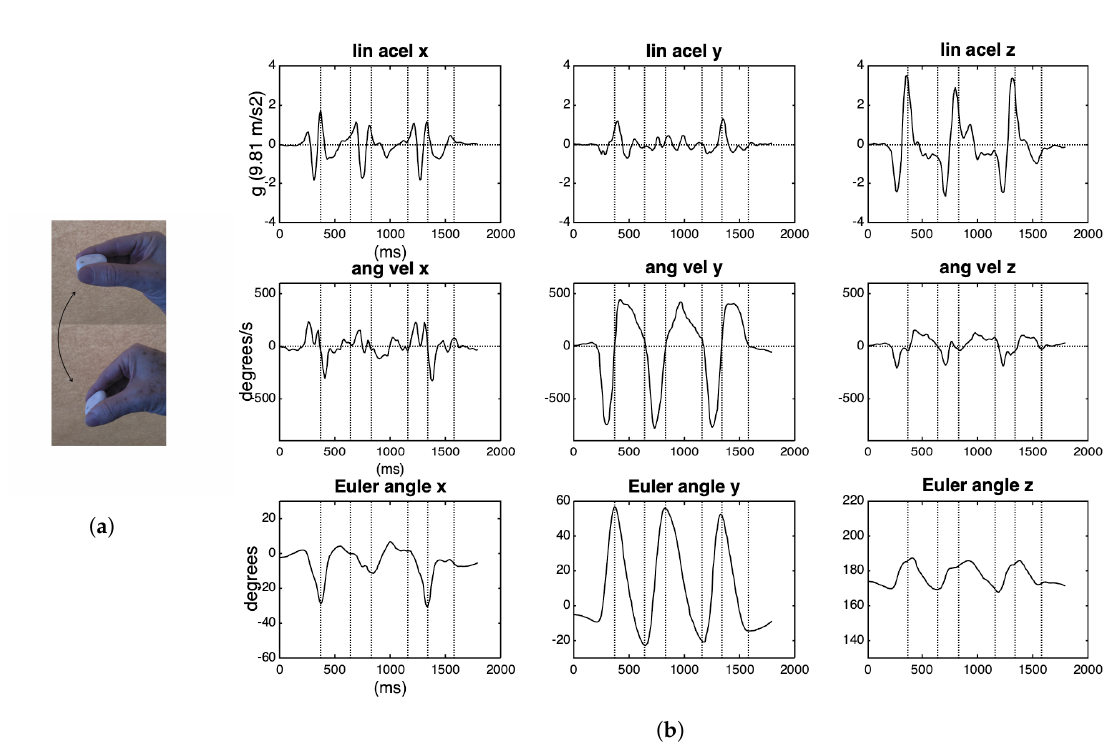
Figure 6. IMU data from six wrist rotations. ( a ) Wrist rotation. ( b ) Curves of three-dimensional (3D) accelerations, angular velocities and Euler angles of wrist